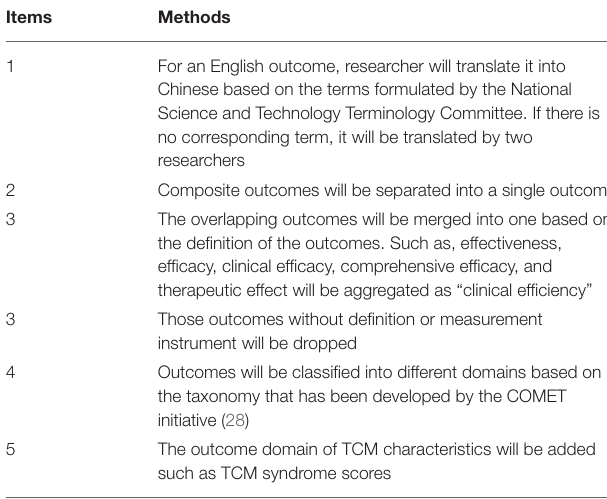
TABLE 3 | The details of the outcomes merging and grouping methods.